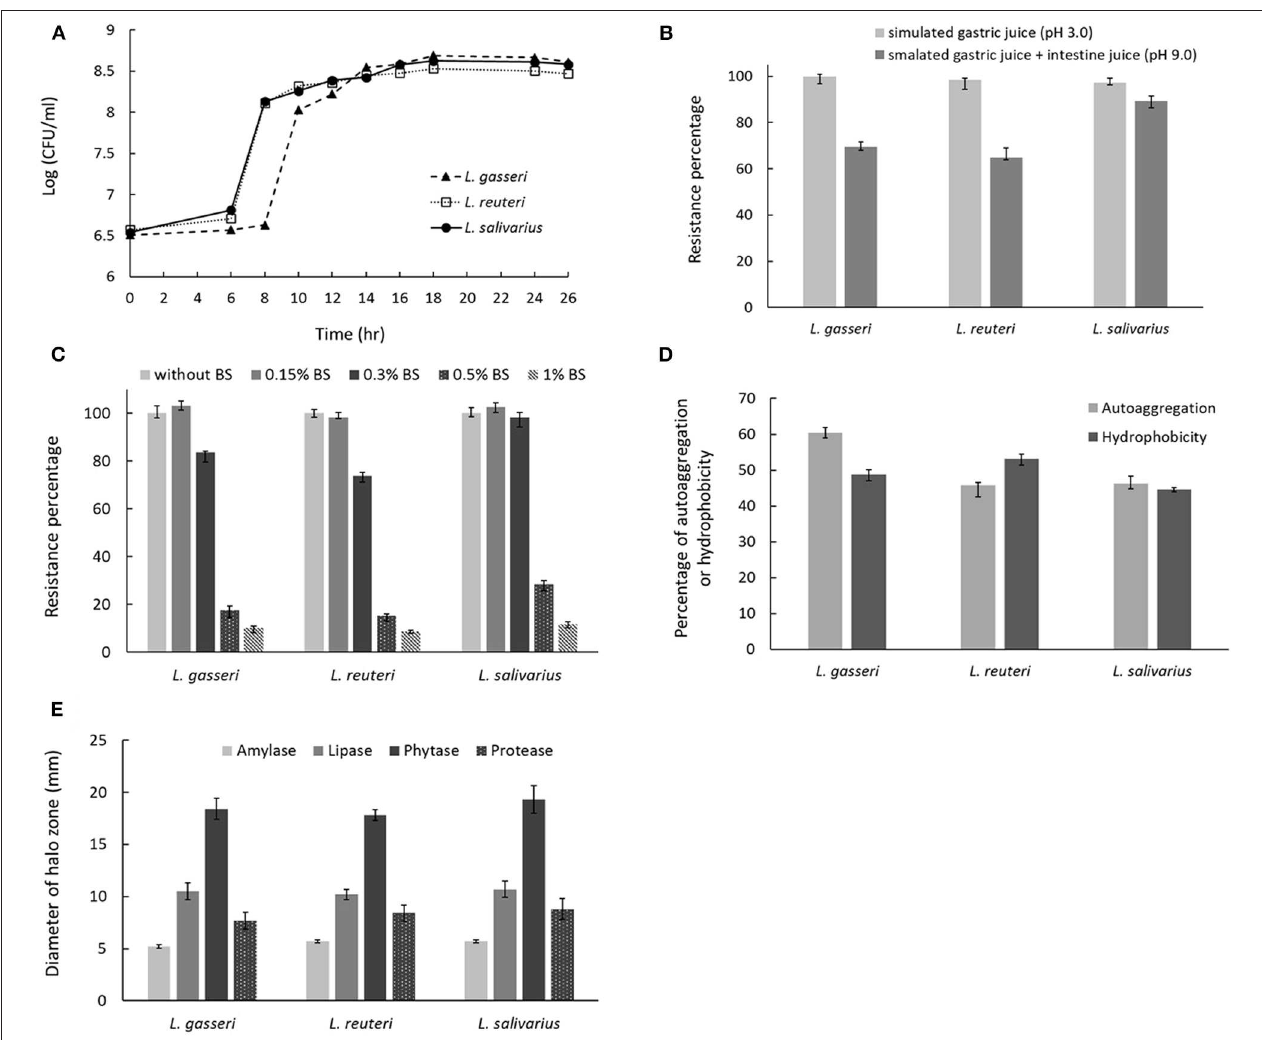
FIGURE 3 | Characterization of probiotic properties of Lactobacillus strains. (A) The growth curves for the three Lactobacillus strains in MRS broth. The effect of incubation in (B) simulated gastric and intestinal juices or (C) bile salts on cell viability. (D) Evaluation of strain autoaggregation propensity and surface hydrophobicity. (E) Measurement of digestive enzyme activities, including amylase, lipase, phytase, and protease by spot inoculation method using different agar medium. Enzymatic activity was determined by measuring the diameter of clearing zone surrounding the colonies.